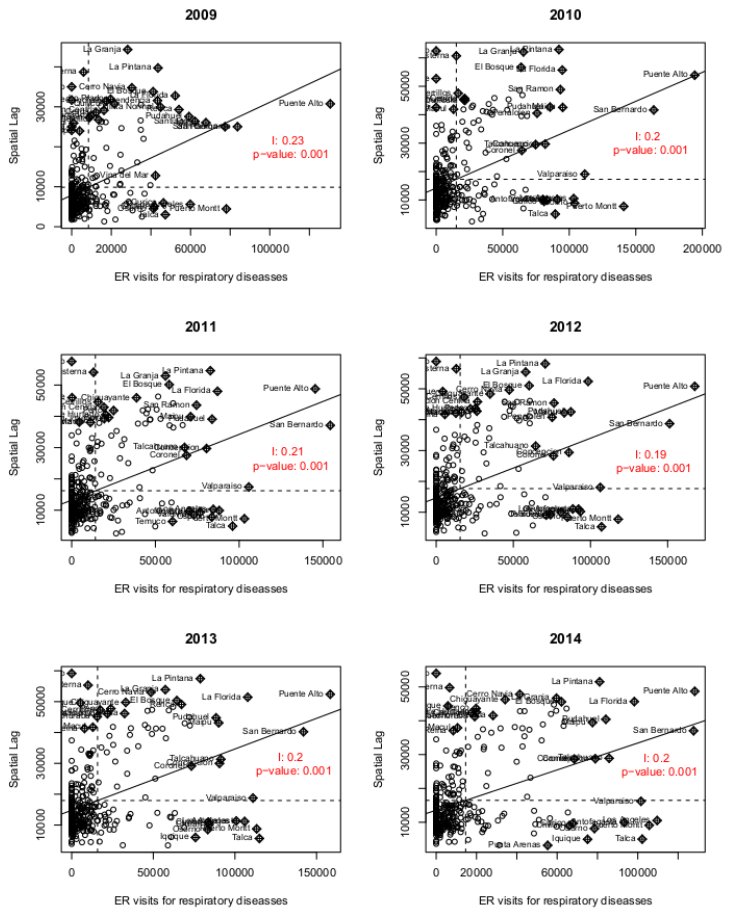
Figure 3: Moran’s scatterplots for average ER visits for respiratory diseases: Moran’s I test and p-value by